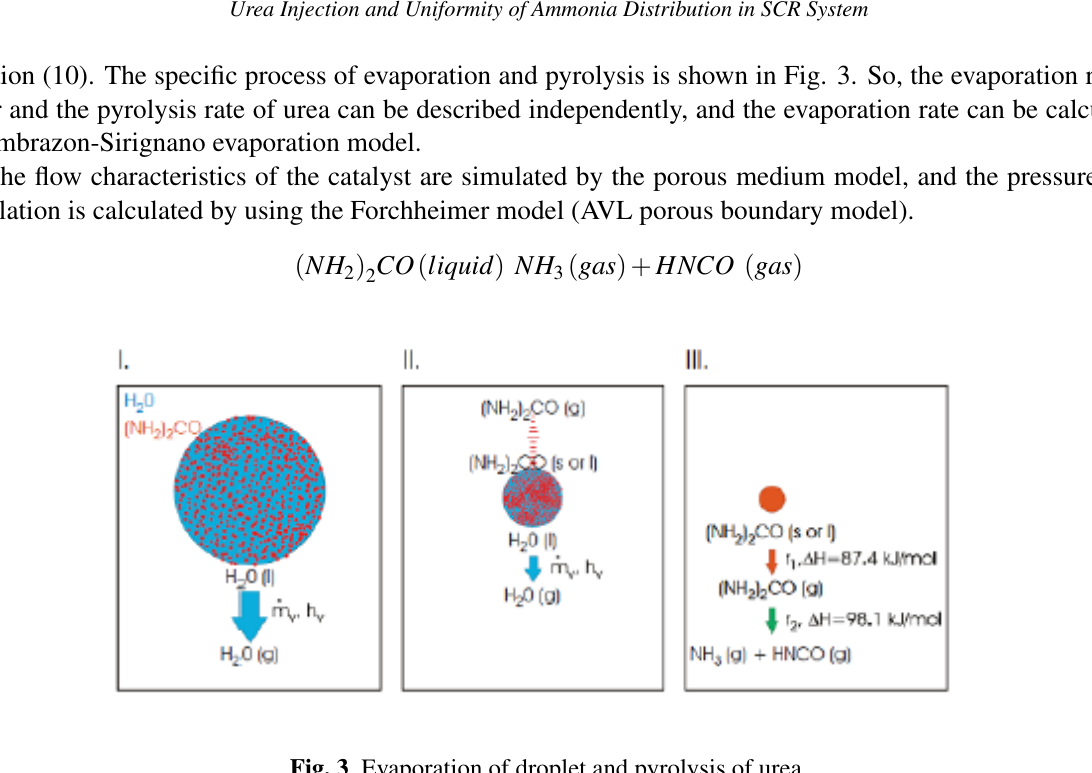
Fig. 3 Evaporation of droplet and pyrolysis of urea.